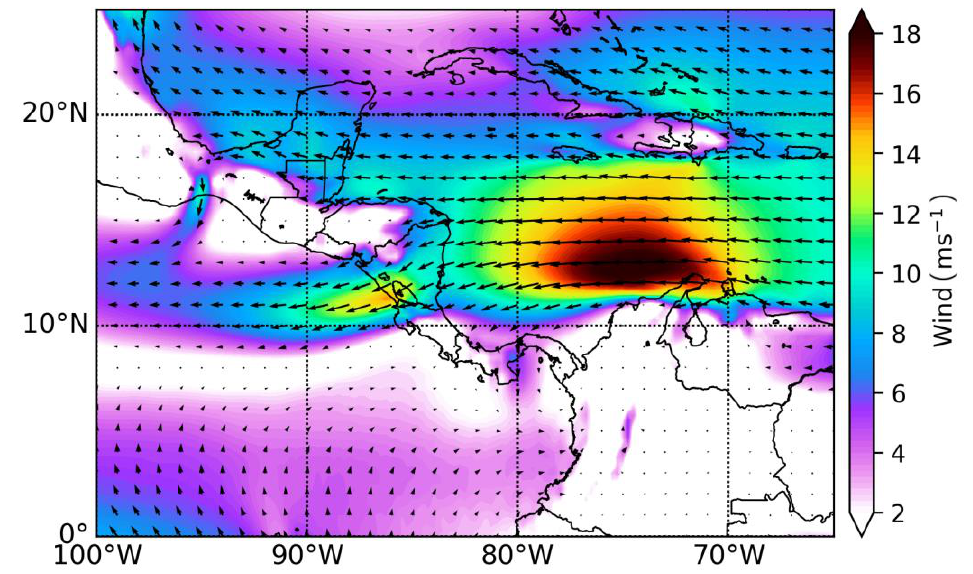
Figure 5. Average July monthly wind speed at 925 hPa from ERA5 over the Extended Central Amer- ica for 2012–2020. (https://climatedataguide.ucar.edu/climate-data/era5-atmospheric-reanalysis, ac- cessed on 12 May 2021).